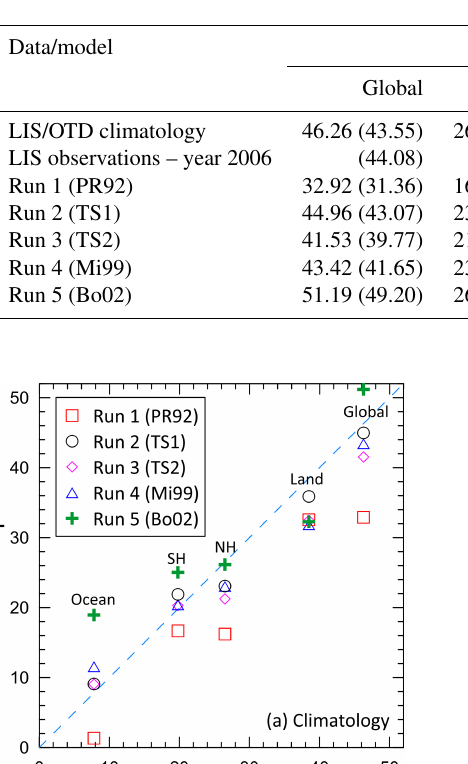
Table 1. Observed and simulated lightning flash frequencies for the various model runs. The values in the parentheses are for the latitudinal range ± 42 . 5 ◦ (which correspond to the latitudinal coverage of the LIS data).